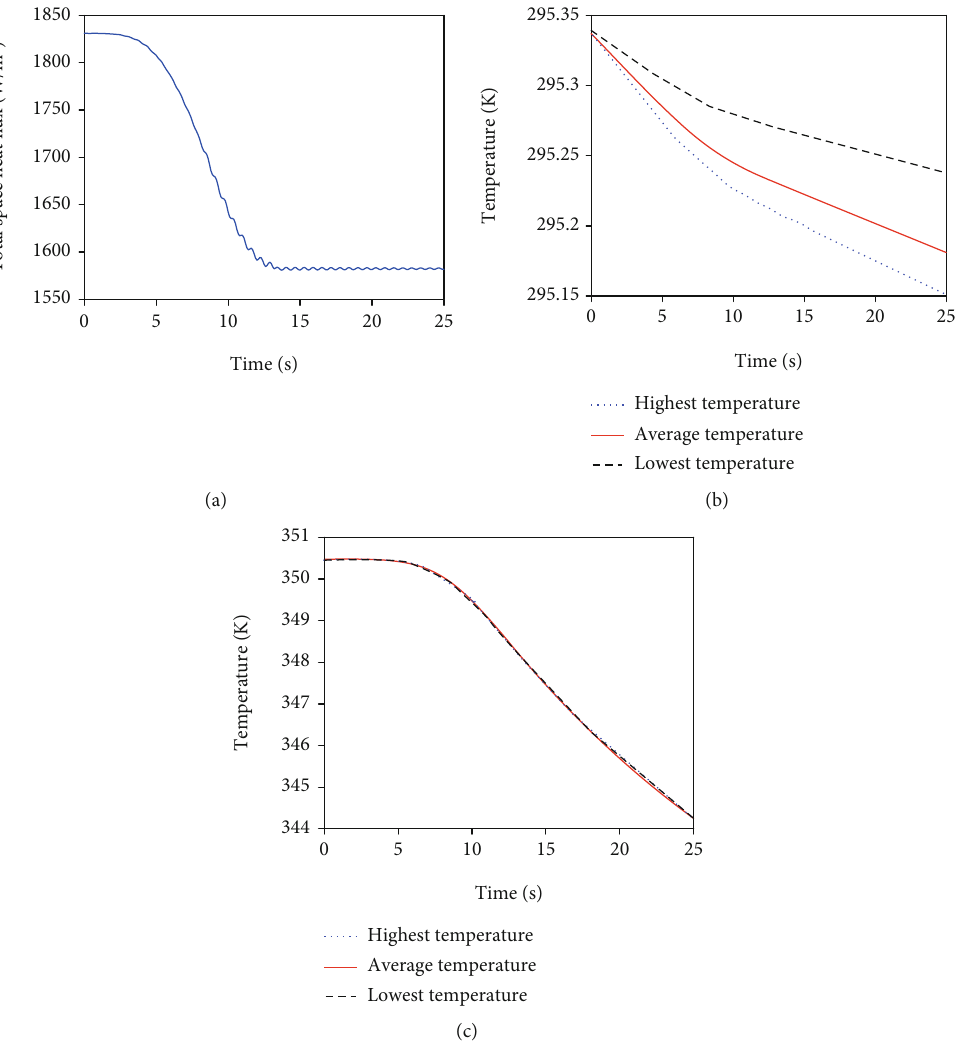
Figure 12: Heat fl ux and temperature of the membrane antenna structure during attitude maneuver: (a) heat fl ux absorbed by the structure; (b) temperature of the support frame; (c) temperature of the membrane